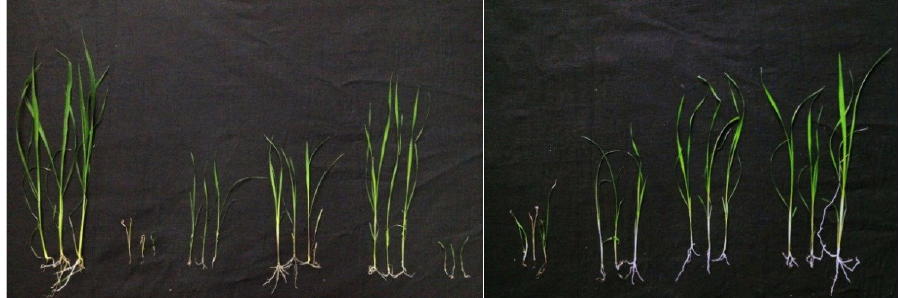
Figure 3. Photographs showing the lateral development of monocotyledon barnyard grass with compounds 5-A3 , 5-B4 at different concentrations with a pot